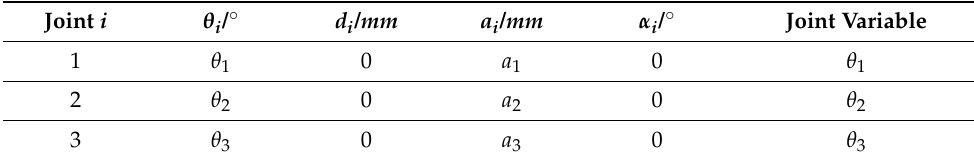
Table 2. Joint Denavit–Hartenberg Coordinate Parameters.